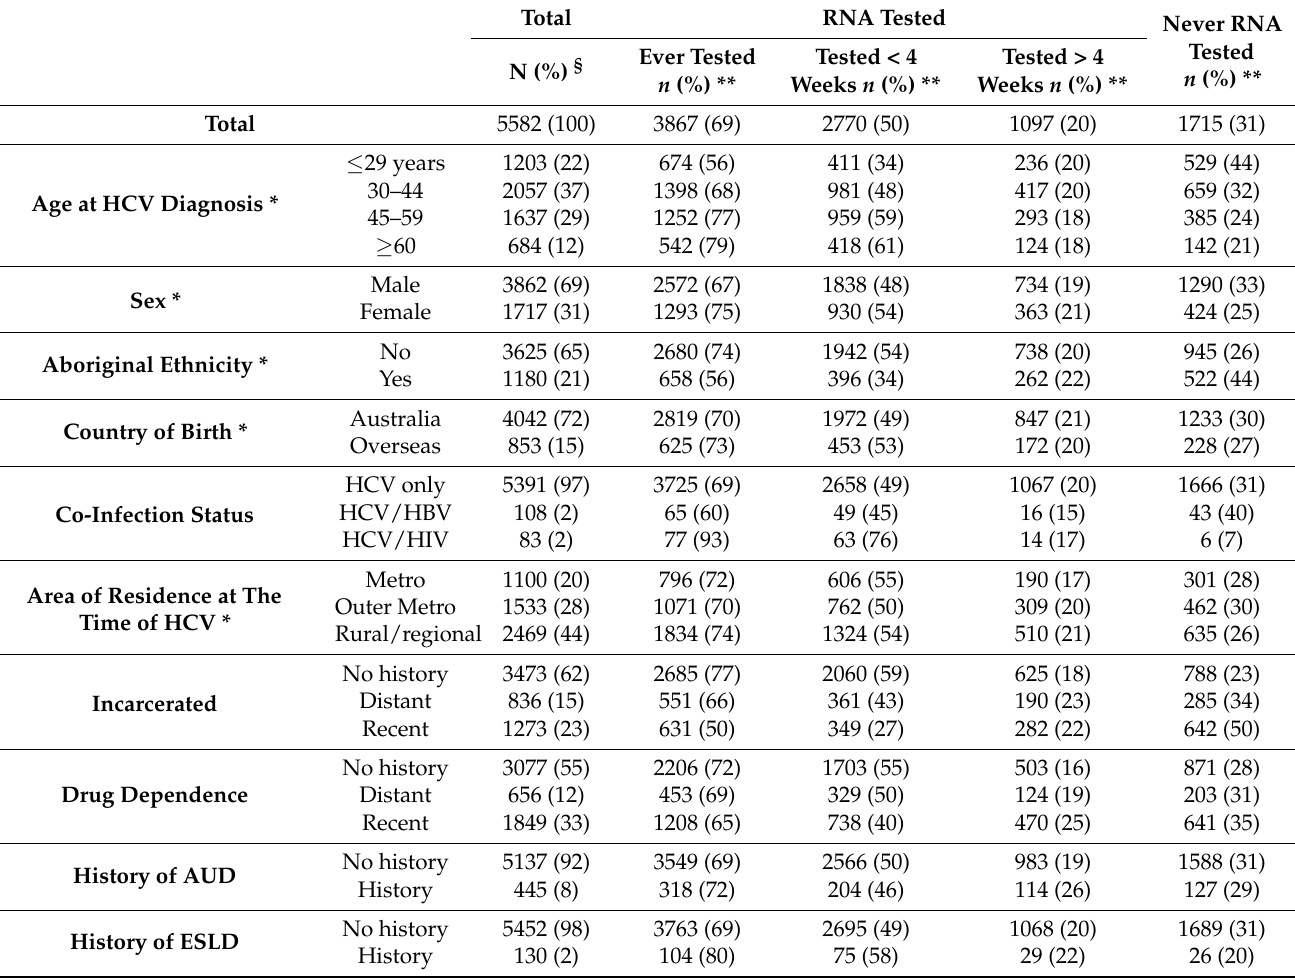
Table 1. The distribution of sociodemographic and clinical characteristics of people with an HCV notification across different periods of time to RNA testing in NSW 2016–2018 (N = 5582).